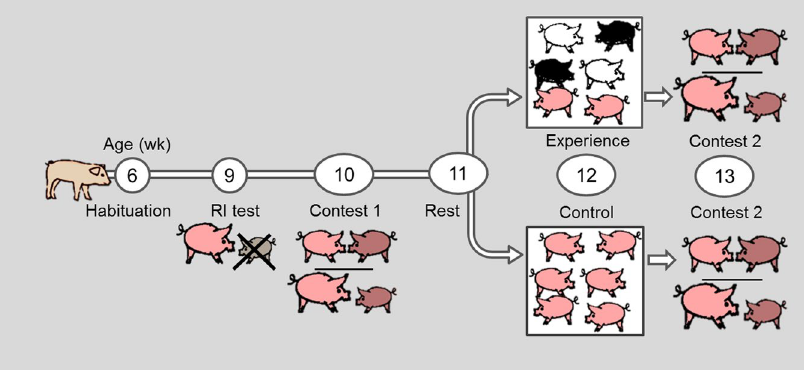
Figure 1. Experimental design. Graphical presentation of the various tests by week of